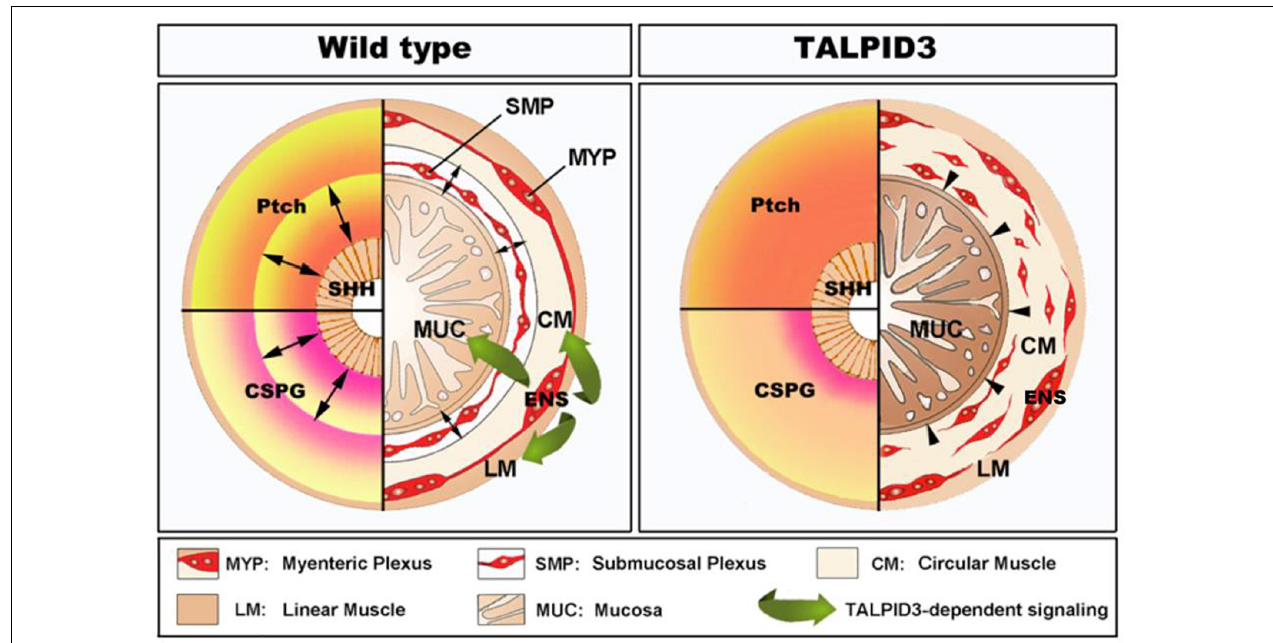
FIGURE 8 | Model of TALPID3-dependent gastrointestinal neuromuscular patterning. During normal gut development (Left) , the Sonic Hedgehog (SHH) gradient defines the concentric architecture of the intestine as seen by the discrete PATCHED (Ptch) pattern of expression. SHH readout in the mesenchyme immediately adjacent to the epithelium restricts smooth muscle differentiation to allow the connective tissue of the submucosa to develop. In the absence of a functional TALPID3 protein (Right) , the SHH readout is lost, as shown by the diffused Ptch expression. Loss of the SHH readout leads to ectopic spread of the smooth muscle differentiation domain adjacent to the epithelium. (Left – bottom) During normal gut development, the precise readout of the SHH gradient directs the pattern of CSPG expression, restricting ENCC to the locations where the enteric nervous system (ENS) will form. The ENS regulates smooth muscle and mucosa growth and differentiation via a TALPID3-dependent signaling (green arrows). (Right – bottom) In the absence of a functional TALPID3 protein, SHH readout is lost, which coincides with a loss of CSPG expression. This loss of expression permits ectopic ENCC migration resulting in scattered ENCC throughout the gut mesenchyme. Loss of TALPID3 also leads to altered growth and differentiation of smooth muscle and mucosal